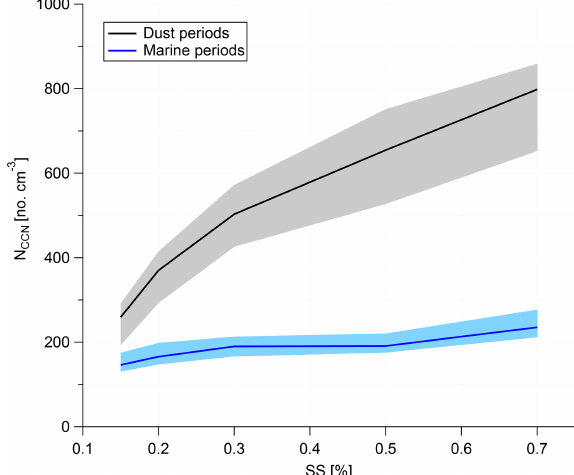
Figure 9. N CCN as a function of supersaturation during dust (black line) and marine (blue line) periods. The shading shows the 25th to 75th percentiles.